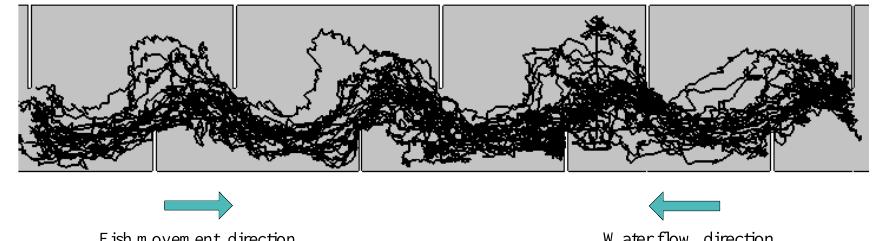
Figure 3. The typical movement trajectories of carps in pool 2–5.